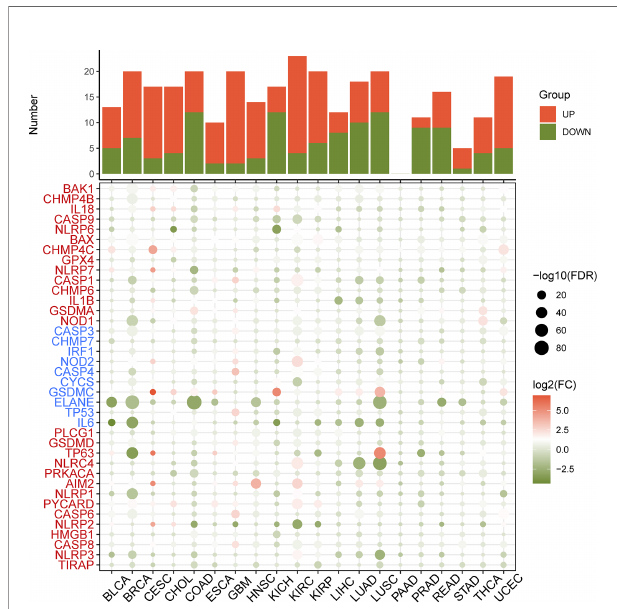
FIGURE 2 | Heatmap of the necroptosis gene expression pro fi les in the TCGA dataset. Red: increased expression, green: decreased expression and the circles size represent the false-discovery rate